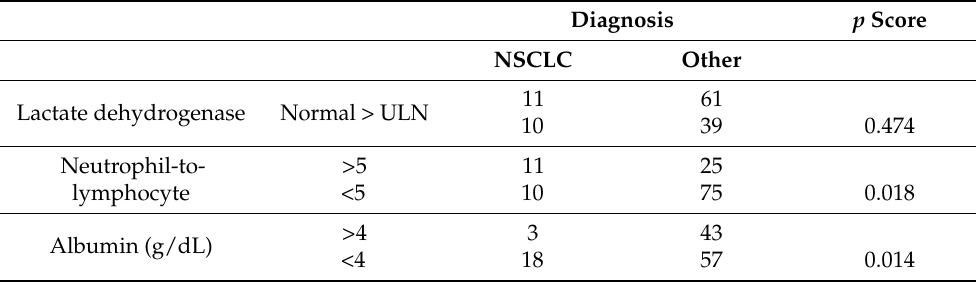
Table 4. Lactate dehydrogenase, neutrophil-to-lymphocyte ratio and albumin status of patients with non-small cell lung cancer or